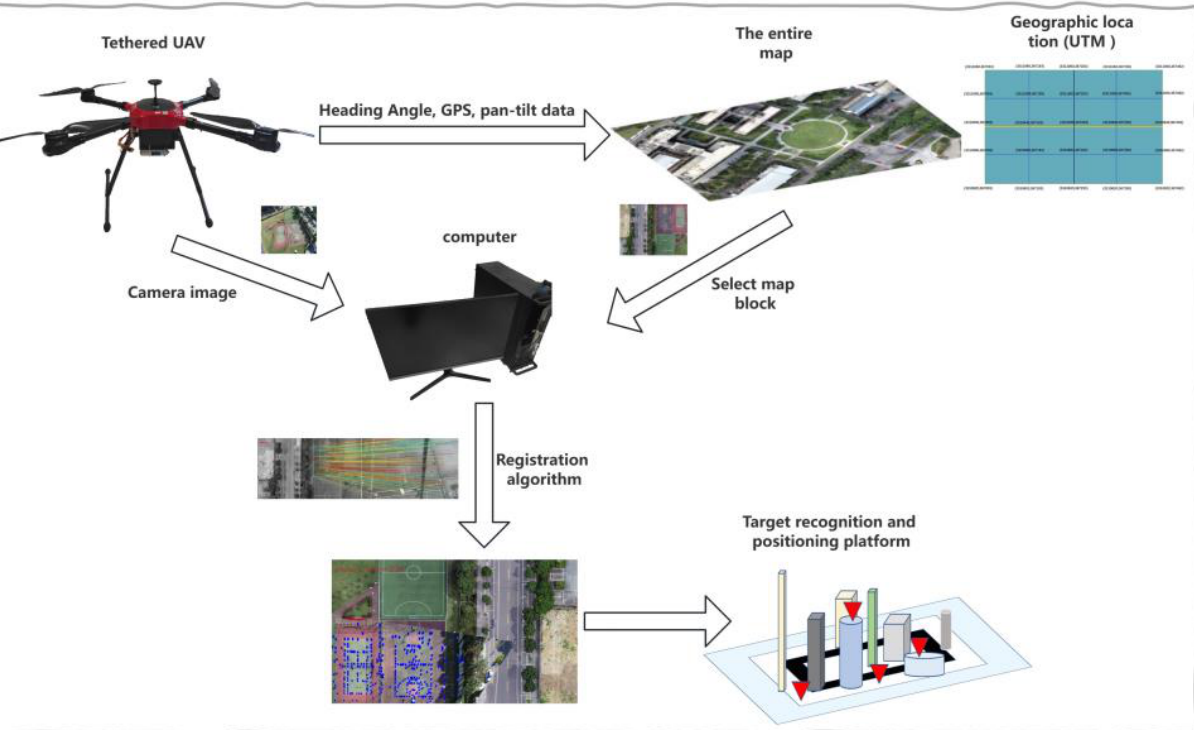
Figure 2. Overall design flow chart. 3.2. Hierarchical Blocking Strategy Combined with Prior UAV Data Through the real-time feature matching of the video picture from the UAV ’ s airborne camera with the map, the camera picture can be accurately registered to the map (the map is an orthographic projection of the satellite perspective generated by CC software, as shown in Figure 3). The map is manually calibrated, and the transformation relationship between the pixel and geographic coordinates for the map is as follows: